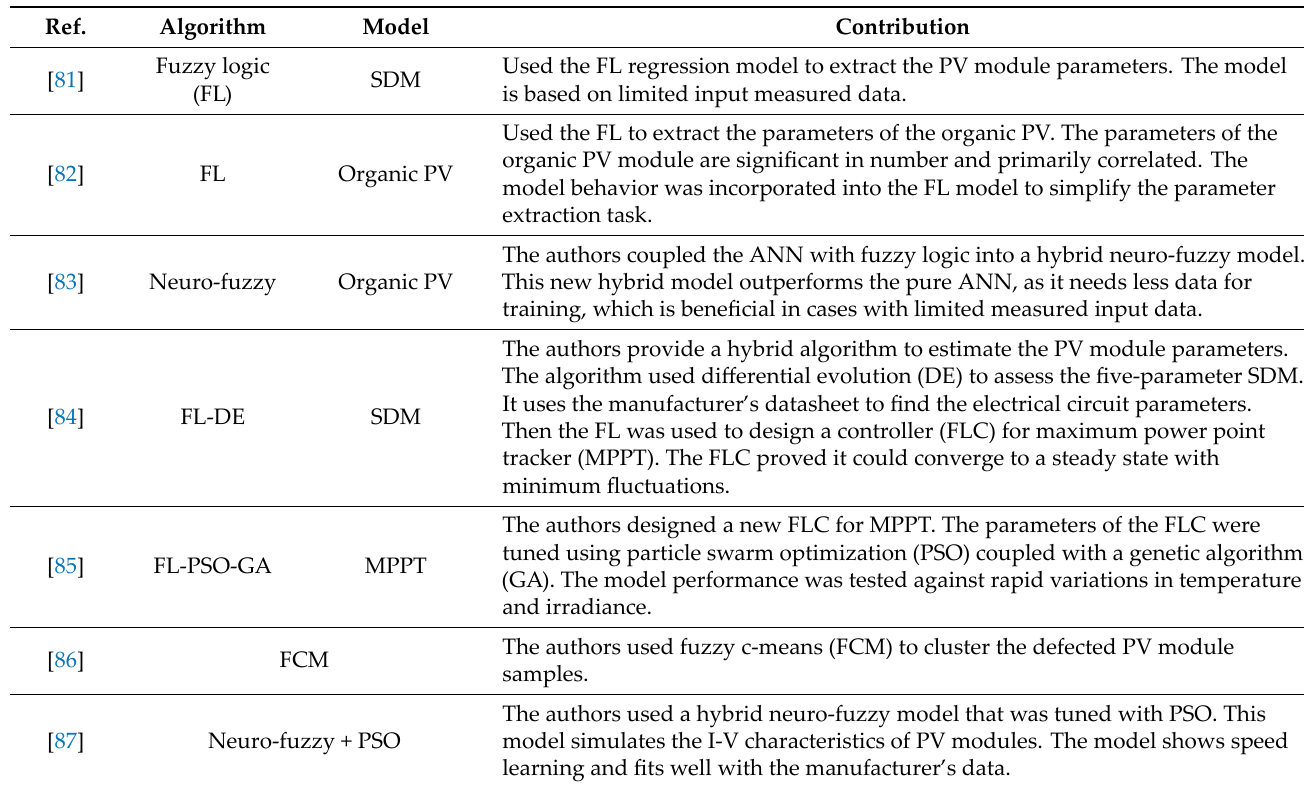
Table 4. Soft computing algorithms—fuzzy logic.